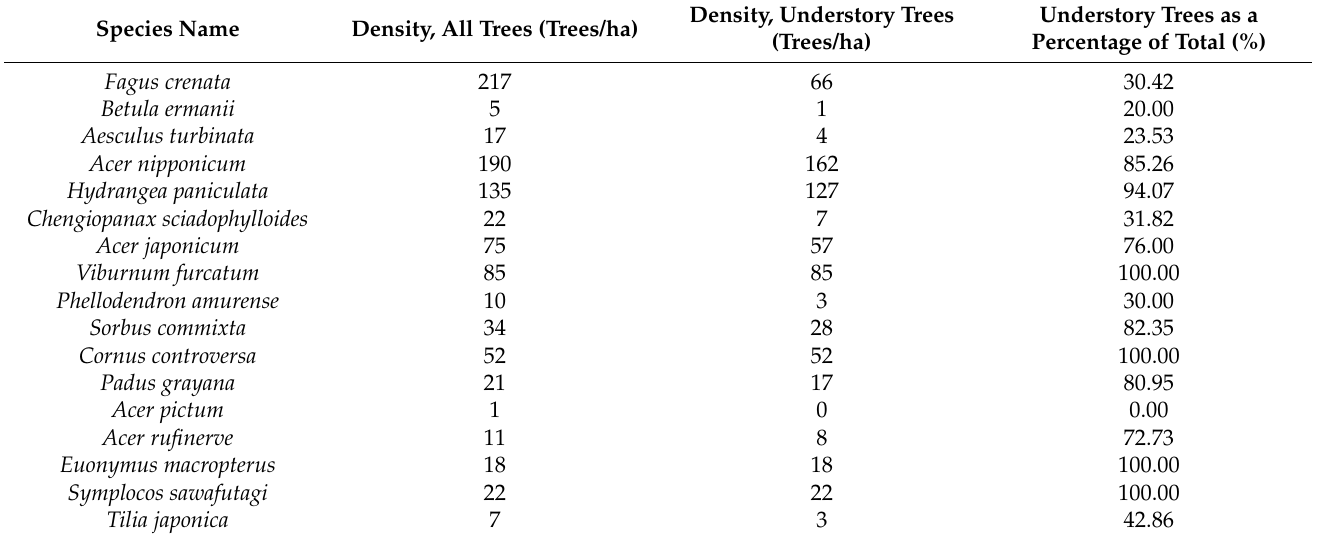
Table 2. Number of total and understory trees of each species and understory trees as a percentage of total trees for each